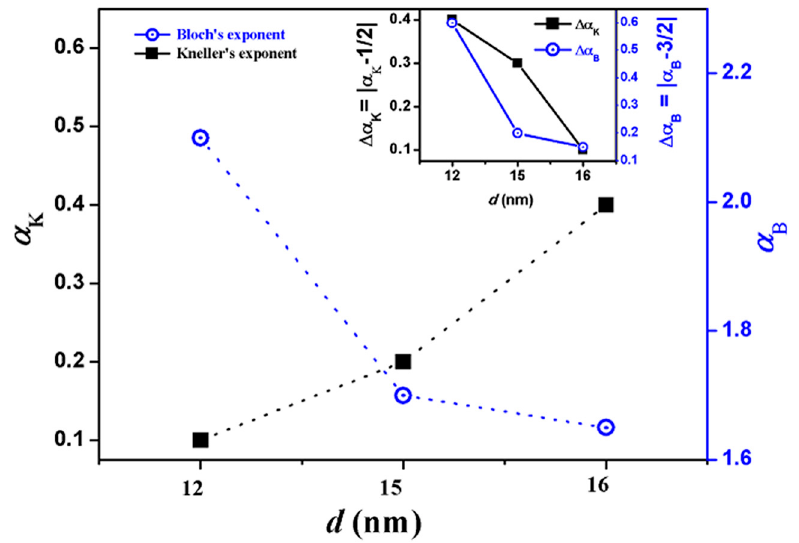
Figure 7. The Kneller’s exponent ( α K ) and the Bloch’s ( α B ) exponent versus particle diameter. The inset shows the absolute differences of the Kneller’s and Bloch’s exponents from the exponents in the original laws.